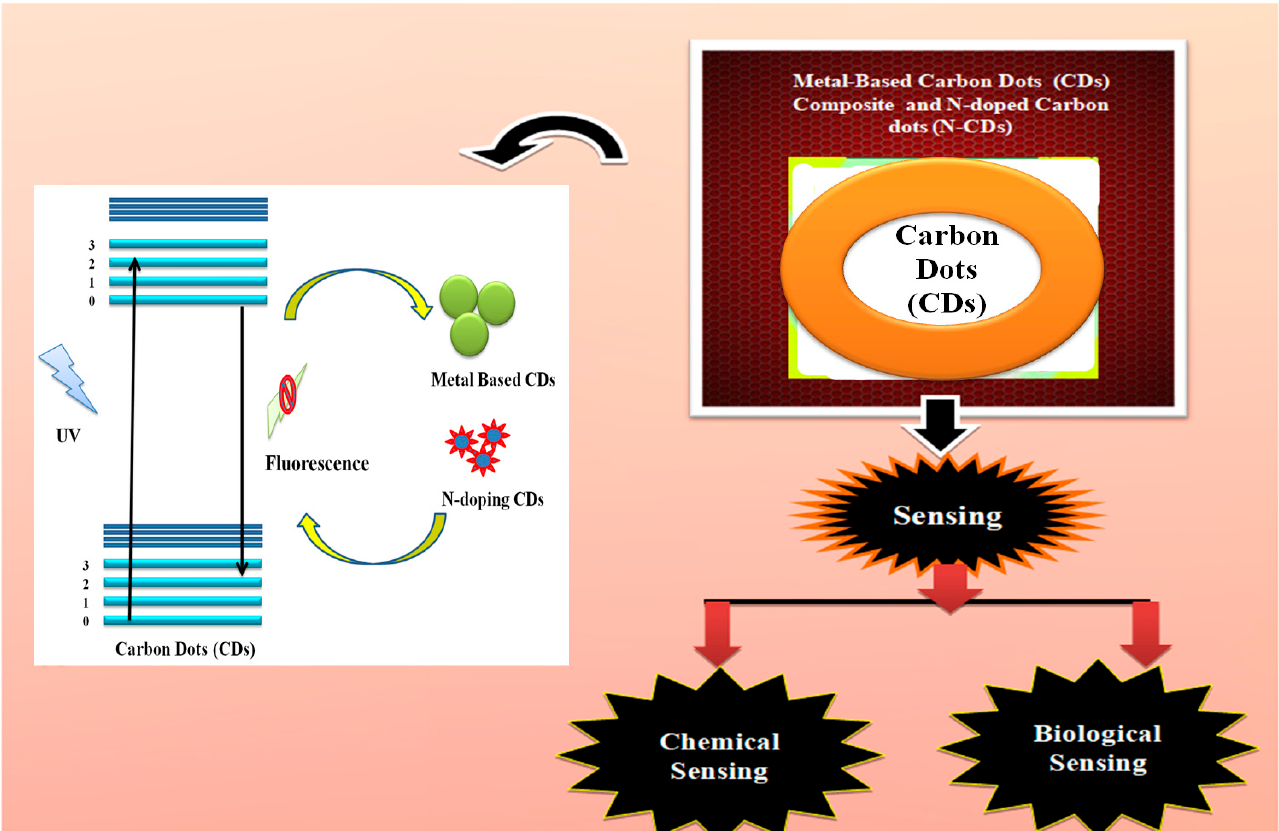
Figure 1. General overview of this work. The potential of CDs as a component of N doping and metal or metal oxide composite materials for chemical and biological sensing is highlighted.